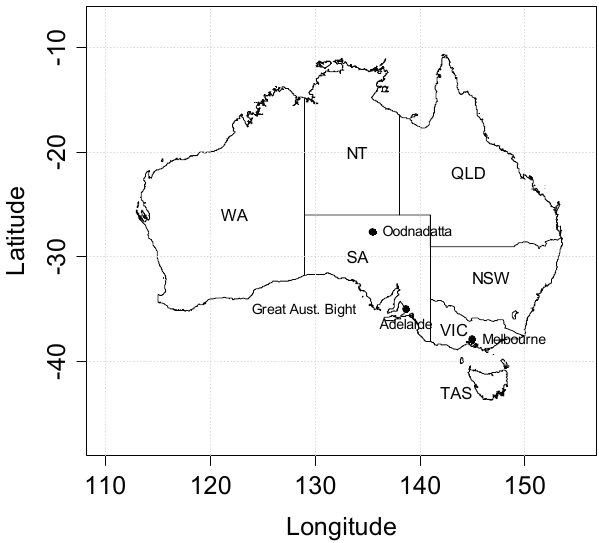
Figure 1. Map showing the Australian States/Territory and other locations mentioned in the